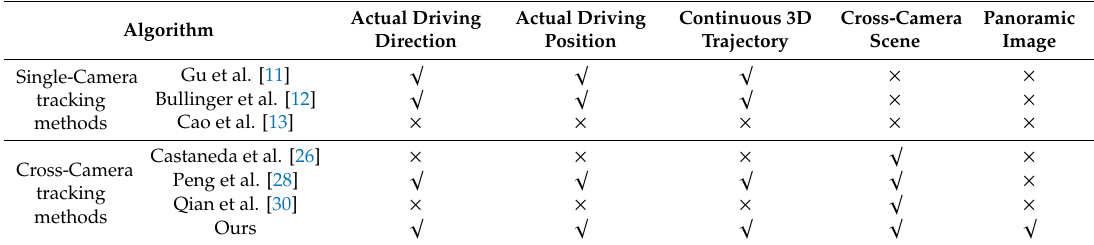
Table 8. Comparison of di ff erent 3D trajectory extraction algorithms.